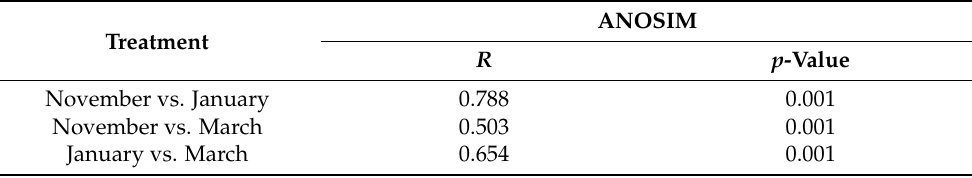
Table 5. The ANOSIM test was used to compare differences in the intestinal bacteria of hooded cranes.